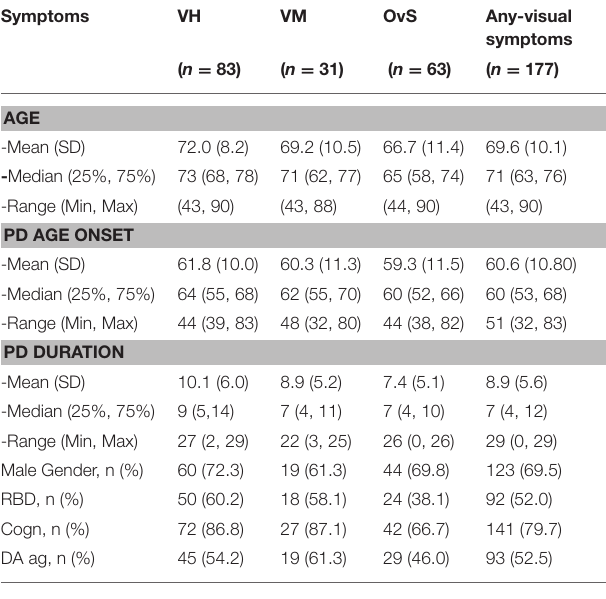
TABLE 1 | Demographic and clinical features of PD sample.